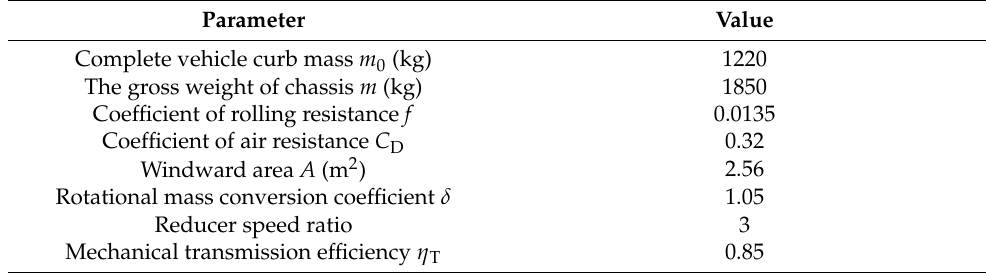
Table 1. Main parameters of the MSEH-HEV.